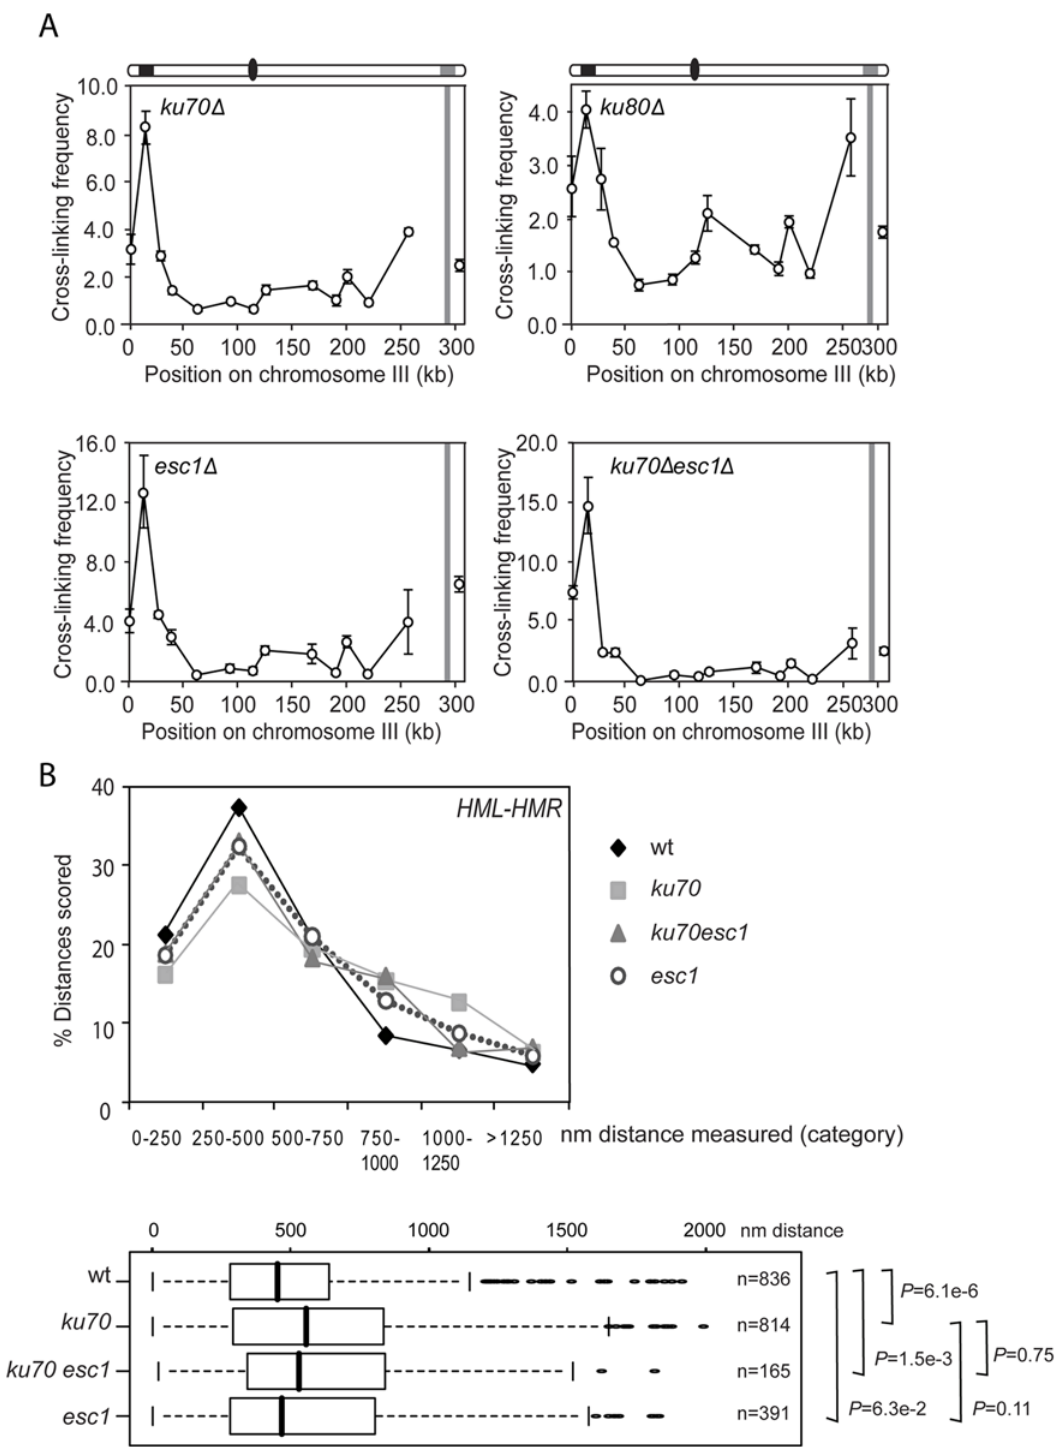
Figure 5. HM Interaction is independent of telomere anchorage mutants. (A) 3C analysis of interactions in yku70 D , yku80 D , esc1 D , and yku70 D esc1 D cells examining cross-linking frequencies between the EcoRI fragment containing HMR with other restriction fragments along the length of chromosome III. (B) 3D live cell analysis of HML-HMR colocalization in yku70 D , esc1 D and y ku70 D esc1 D cells. Image stacks were acquired and analyzed as in Figure 1. Distance distributions of HML and HMR represented in box plots. Probabilities were calculated in R using the Wilcox test. appears that in the absence of yKu70p more nuclei display widely two semi-stable states of silencing: one in which telomeres are separated loci than in wild type ( P = 6.1e 2 6 wt vs yku70 D ). This delocalized and one in which they remain clustered [51]. Finally, may be related to the fact that populations of yku70 D cells display we found that colocalization of HML and HMR in yku70 D esc1 D